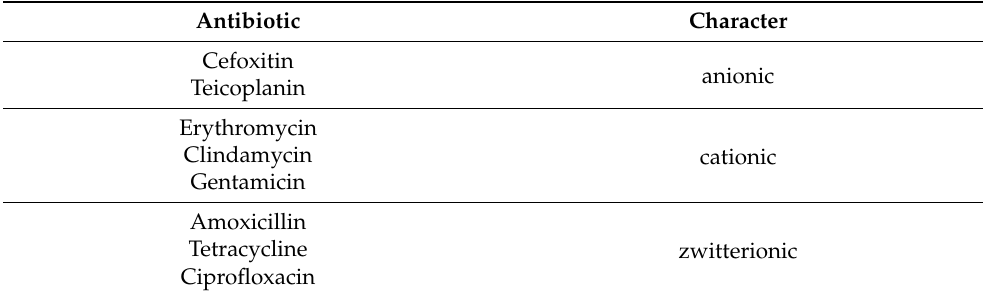
Table 4. Character of antibiotics selected for the study depending on their